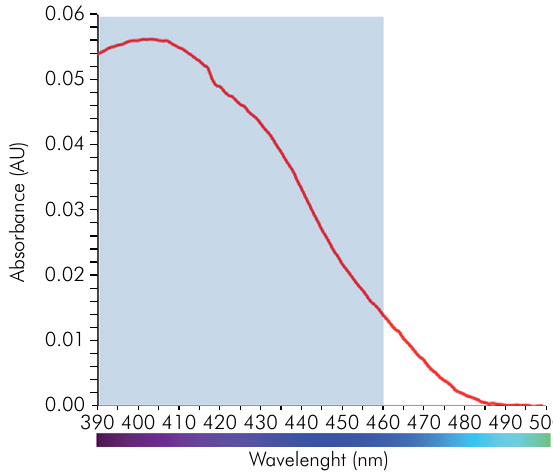
Figure 11. Visible light absorption of Ivocerin® is seen to span from about 390 to 445